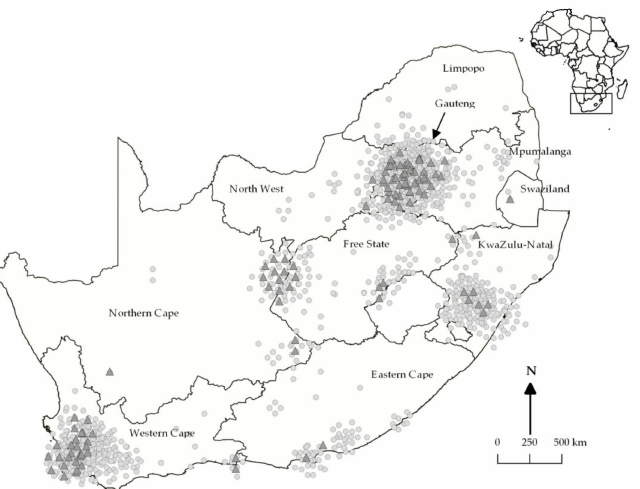
Figure 1. Locations of equine encephalosis virus PCR-positive (triangles) and -negative (circles) samples from horses, South Africa, 2010–2017. Inset shows location of South Africa in